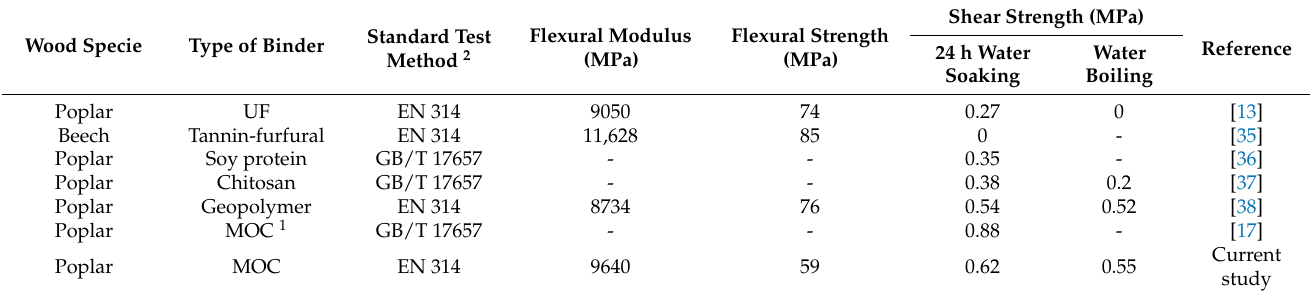
Table 5. Selected properties of plywood bonded with different binder.